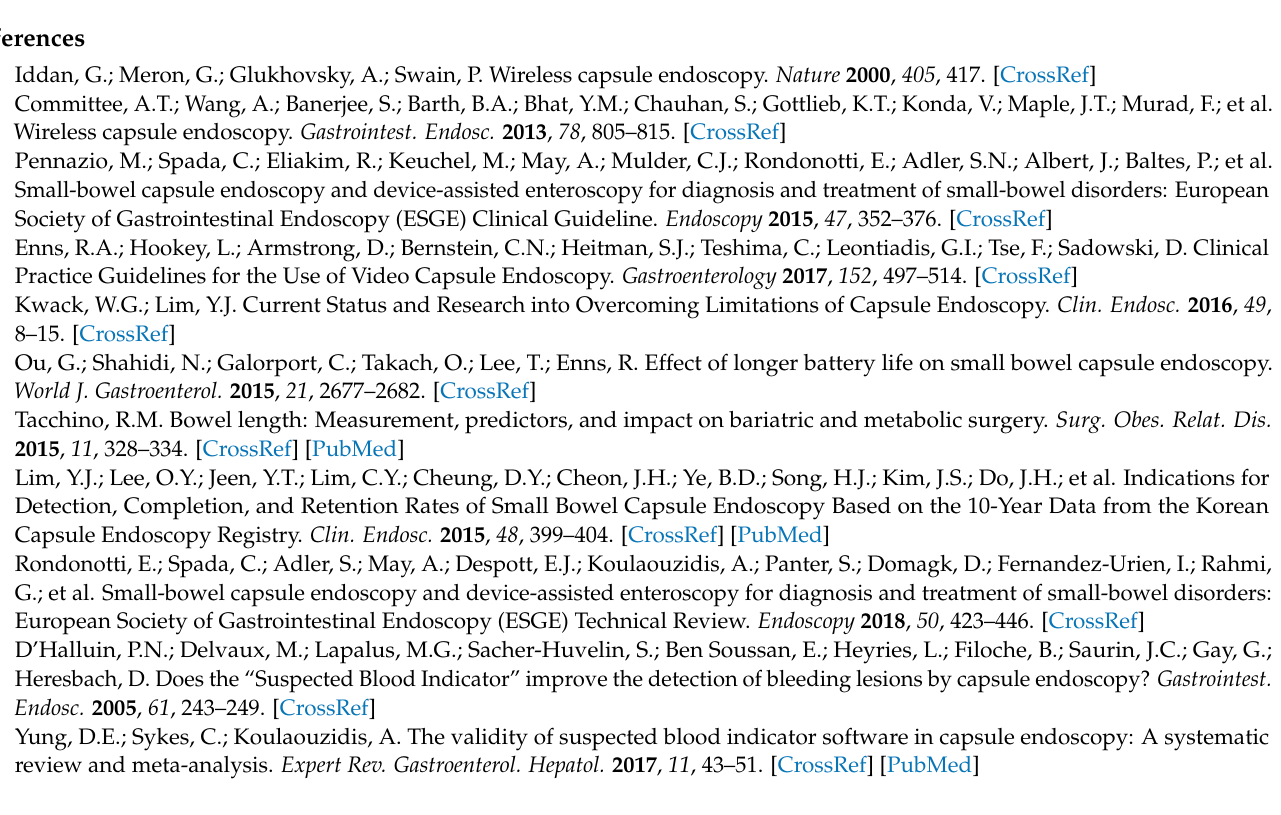
Figure 2. Proposed schematic diagram of an integrated artificial intelligence (AI) algorithm used to read a small bowel capsule endoscopy. First, an AI algorithm identifies the duodenal image and cecal image in the full-length capsule video. Then, the AI algorithm differentiates the suspected lesions from the normal mucosa in the entire small bowel. Finally, the clinician confirms the significant lesion. An integrated AI algorithm composed of AI algorithms in charge of each function will be more useful in actual clinical